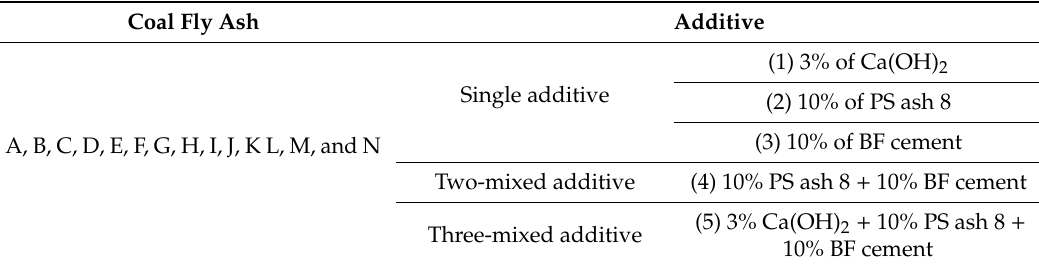
Table 3. Ratio of additive in fly ash for leaching